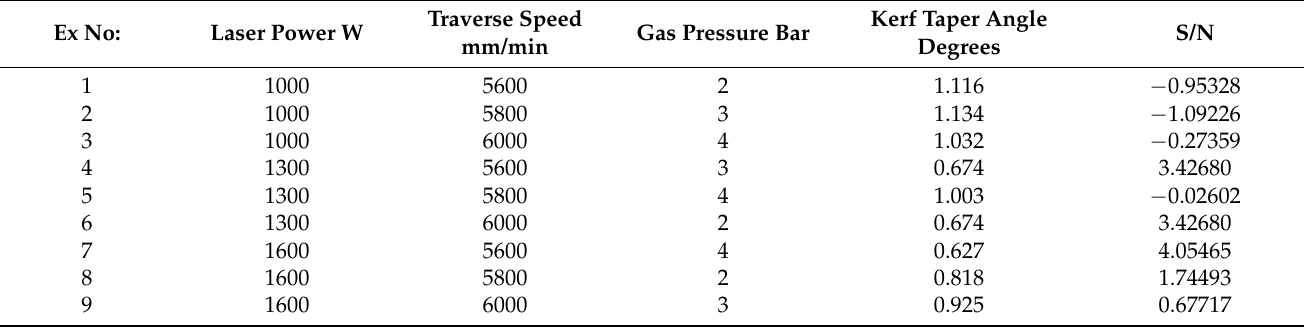
Table 10. L9 array of input parameter levels with measured Kerf taper angle θ ◦ in degrees and calculated signal-to-noise (S/N) ratio based on the Taguchi method for 4 mm specimen